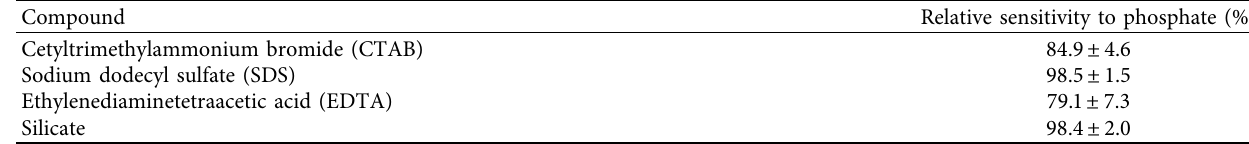
Table 1: Effects of possible interfering species (100 μ M) on measuring phosphate (2.5 μ M) via the PMB-SPE method ( n ˆ 3).